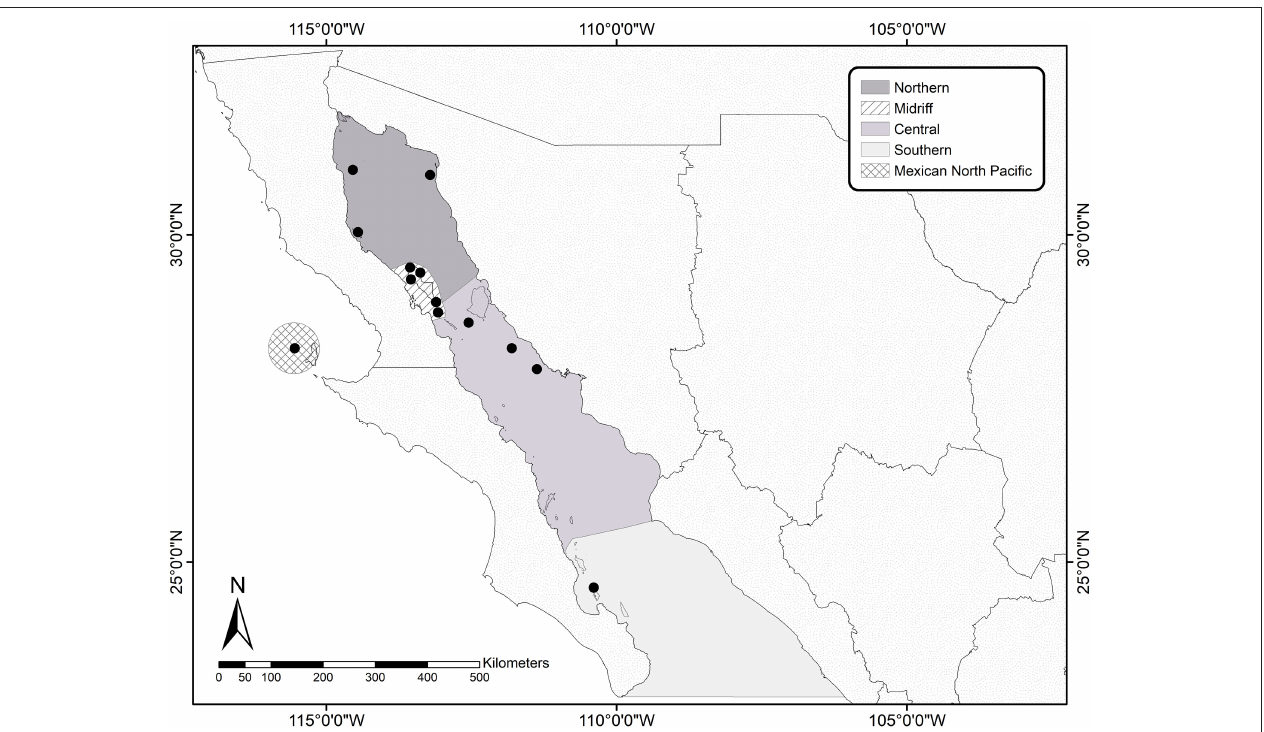
FIGURE 1 | Location of the sampling sites within the Gulf of California and Mexican North Pacific. The map shows the ecological regionalization proposed by Stzeren and Aurioles ( 22) for the Gulf of California and the San Benito Archipelago on the west coast of the Baja California Peninsula, in the Mexican North Pacific. Black dots indicate the colonies where the sea lions were